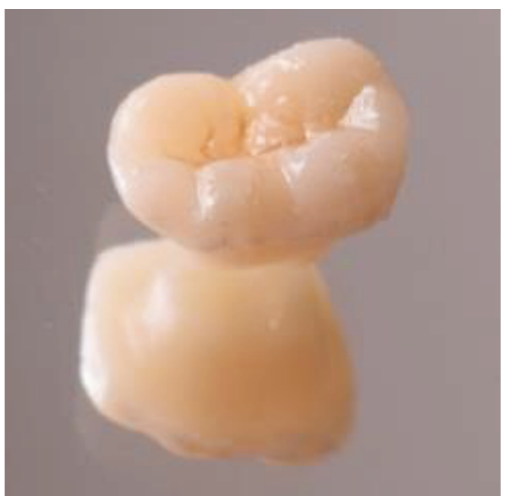
Figure 7: Aspect of the endocrown.